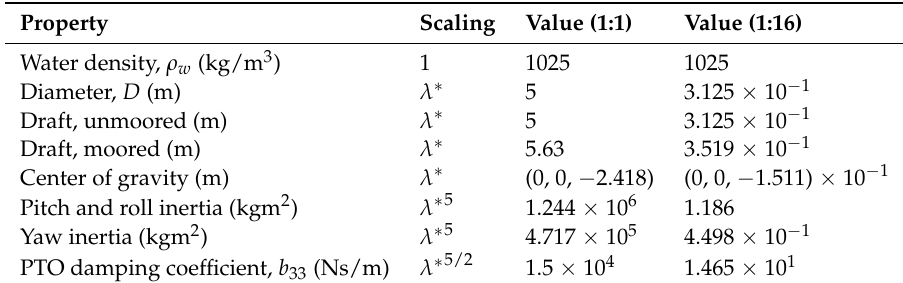
Table 1. Description of the WEC properties in prototype and model scales including scaling